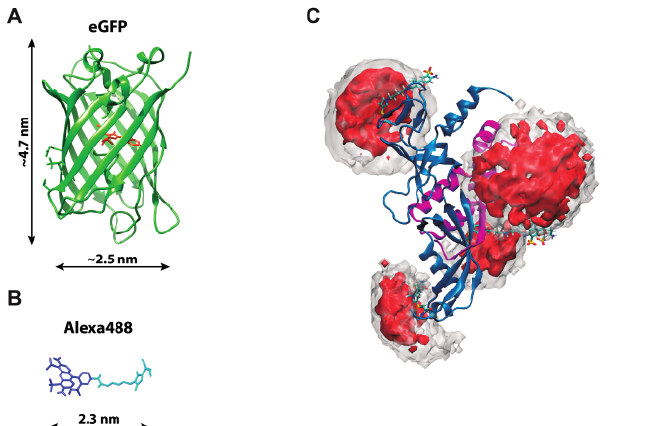
Figure 1. Structure and dimensions of ( A ) the fluorescent protein eGFP (PDB: 4EUL), chromophore highlighted in red); and ( B ) the organic dye Alexa488 (blue) with linker (turquois); ( C ) Coupled to a biomolecule (shown here are RNA polymerase subunits Rpo4/7, PDB: 1GO3, blue and magenta ribbons) the organic dye is restricted in its rotational freedom and samples a defined volume. The dye is attached to different positions of the protein to illustrate how the rotational freedom of the dyes is restricted depending on the protein structure. The conformational space available for the linker-dye molecules can be computed using Monte-Carlo simulations. Clouds envelope 99.5% (gray) and 50% (red) of the total probability (Adapted by permission from PLOS ONE: D. Klose et al. , published: 25 June 2012,